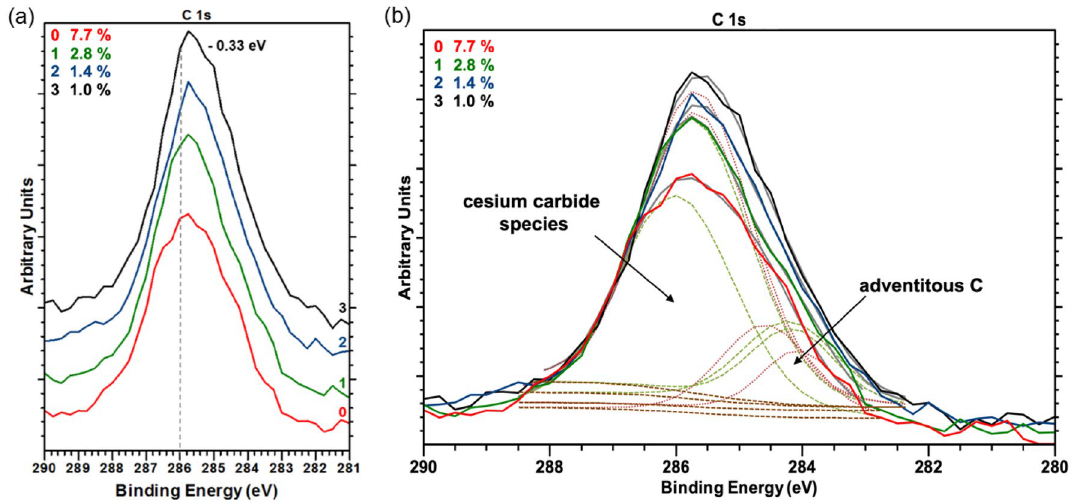
Figure 6. ( a ) Stacked C 1 s photoemission spectra showing the shift to lower BE along with the degradation of the p-GaN:Cs photocathode (sample A) and ( b ) the same C 1 s photoemission spectra (normalized to their background) showing the evolution of the cesium carbide (Cs x C y ) species with peak fittings (dashed lines) along with the degradation.